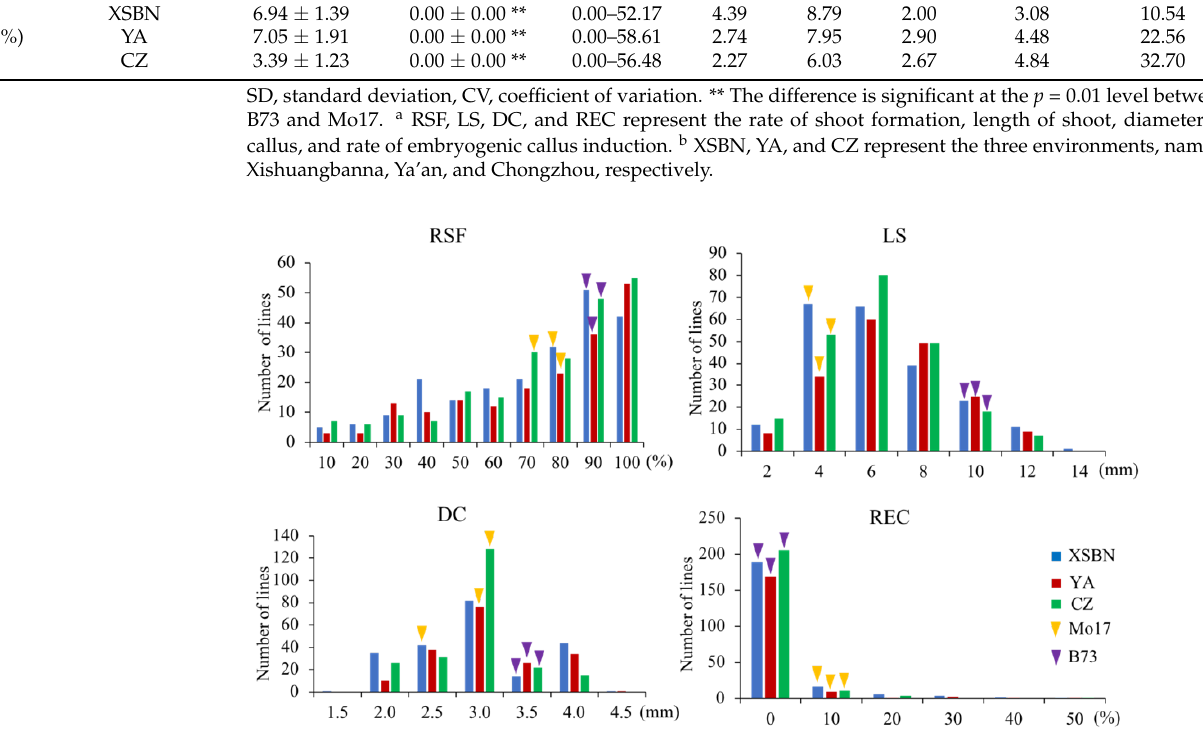
Figure 2. Phenotypic frequency distribution of the IBM Syn10 DH population across three environ- ments. RSF, LS, DC, and REC represent the rate of shoot formation, length of shoot, diameter of callus, and rate of embryogenic callus induction. XSBN, YA, and CZ denote the environments Xishuangbanna, Ya’an, and Chongzhou, respectively. Mo17 and B73 show the two parents of the population. Significantly negative correlations were observed between REC and RSF, REC and LS, and REC and DC in the three environments except for REC and RSF in CZ (Table 2). The correlation coefficients (CCs) of the three pairs of traits ranged from − 0.105 to − 0.342, − 0.134 to − 0.263, and − 0.177 to − 0.318 across the three environments, respectively. Fur- thermore, higher phenotypic correlations between DC and RSF, DC and LS, and LS and RSF were found across different environments, and the CCs ranged from 0.482 to 0.571, 0.612 to 0.715, and 0.692 to 0.737, respectively ( p < 0.01). The broad-sense heritability ( H 2 ) of the four EC induction-related traits varied between 83.17 and 88.27% (Table 3), indicating that genetic factors played dominant roles in the formation of EC. Analysis of variance (ANOVA) revealed that the variances from genotype (G), environment (E), and genotype × environmental interactions (G × E) were all significant for the four traits ( p < 0.01, Table 3). Table 2. Phenotypic correlation between the traits across the three environments. −0.177 * ** and * represent significant correlation at the 0.01 and 0.05 levels by a t -test (2-tailed).